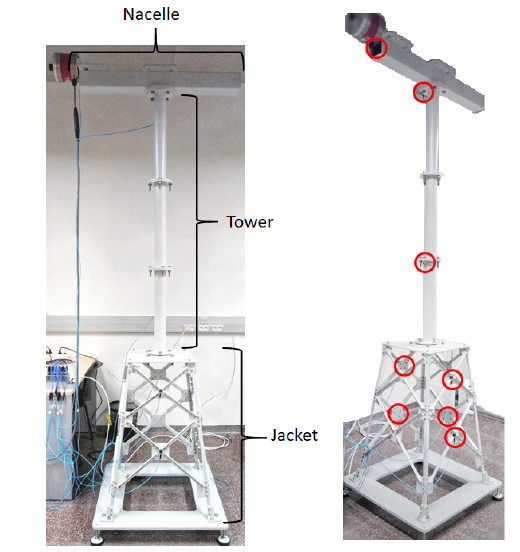
Figure 2. Components of the scale offshore jacket-type support laboratory model ( left ); sensor location on the wind turbine down-scaled model ( right